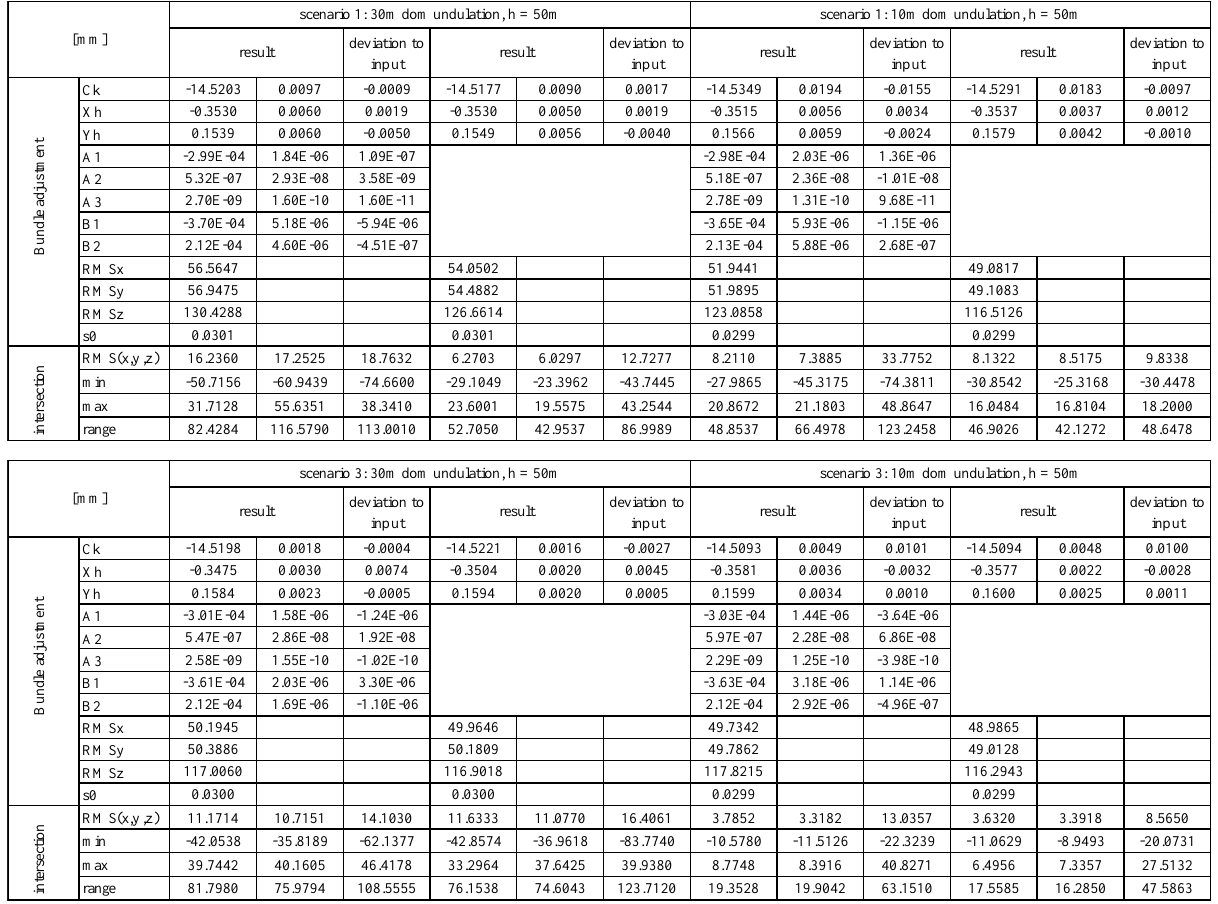
Table 5. Results of flight simulation for scenario 1 and